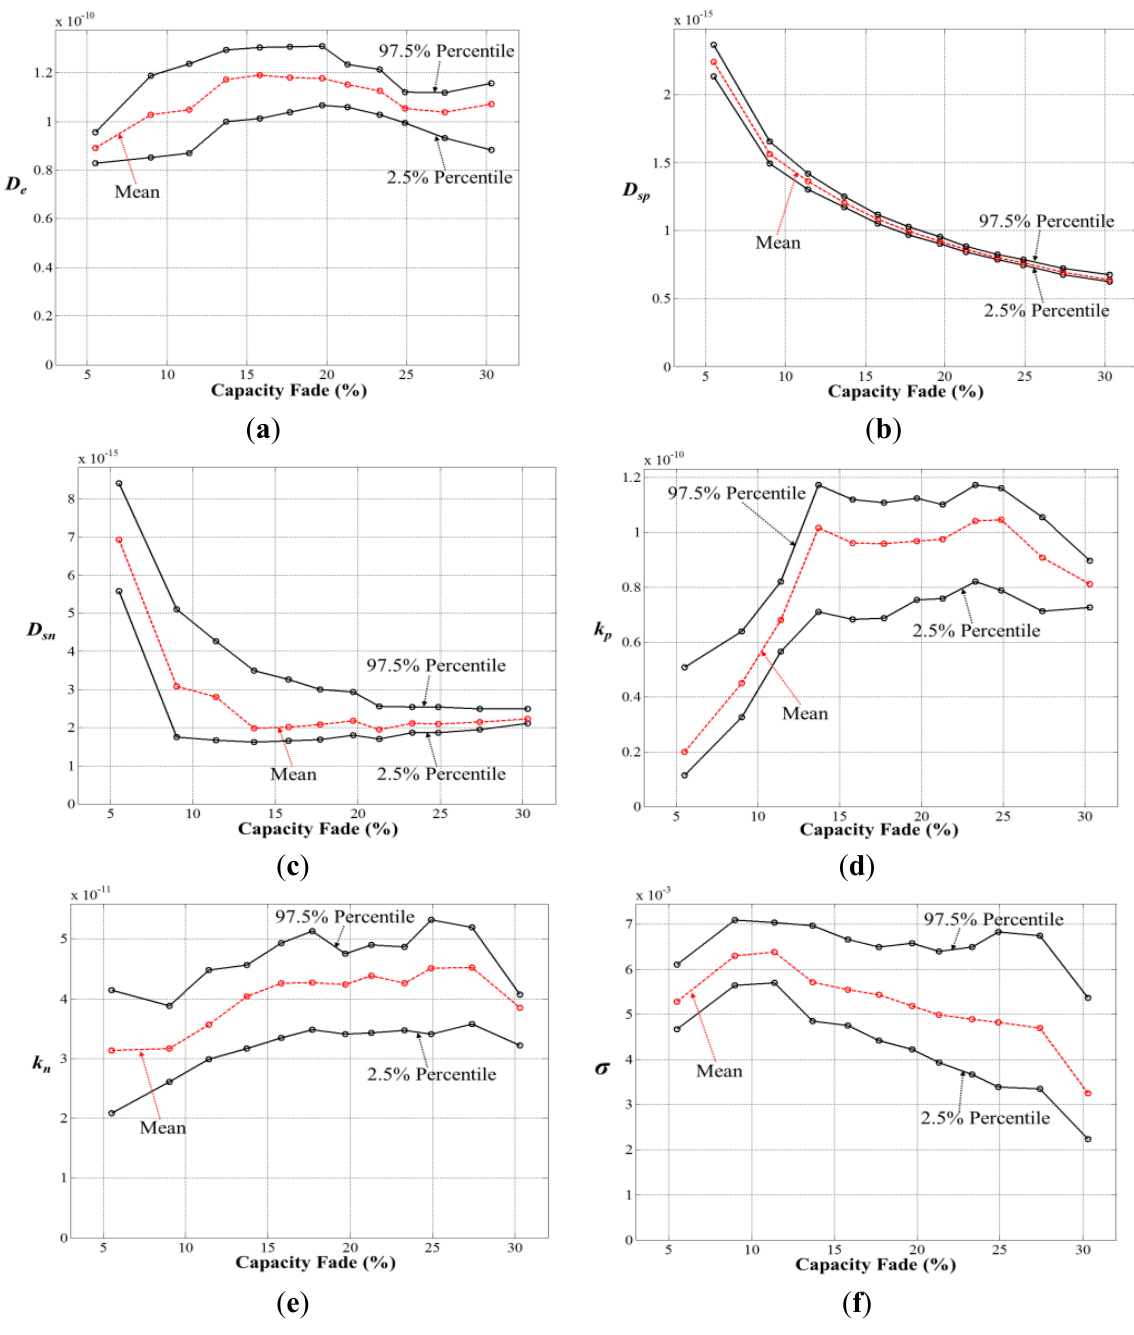
Figure 5. Interval estimation results of battery parameters as capacity fade progresses from 5.5% (cycle 200) to 30.3% (cycle 2400). The 95% confidence intervals and mean values are presented for each model parameter: ( a ) D e ; ( b ) D sp ; ( c ) D sn ; ( d ) k p ; ( e ) k n ; ( f ) σ